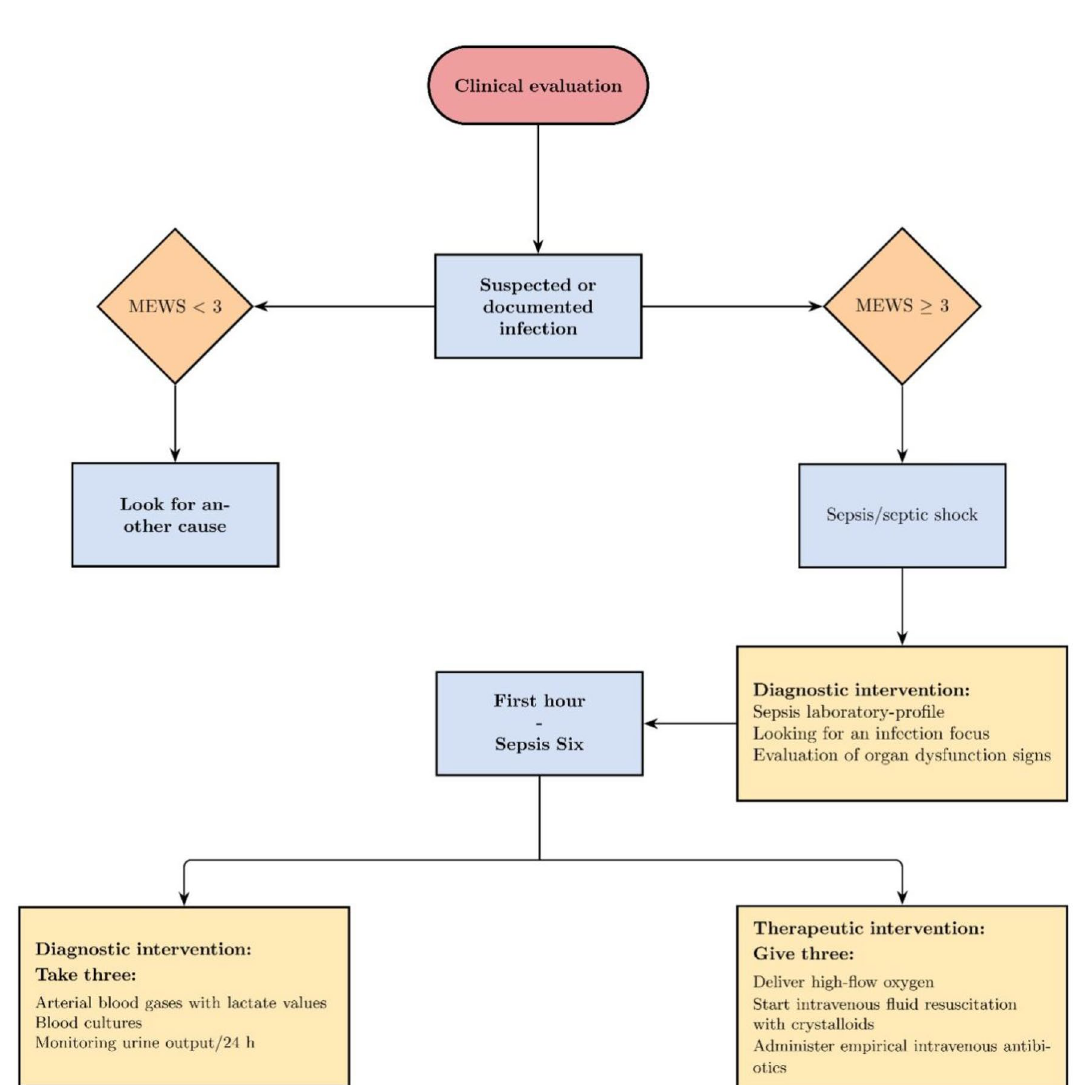
Figure 2. Patient management flow chat at the ER. MEWS modified early warning score. First hour—“sepsis six” box is referred to the 3 diagnostic (take three) and 3 therapeutic (give three) steps to be delivered by staff within 1